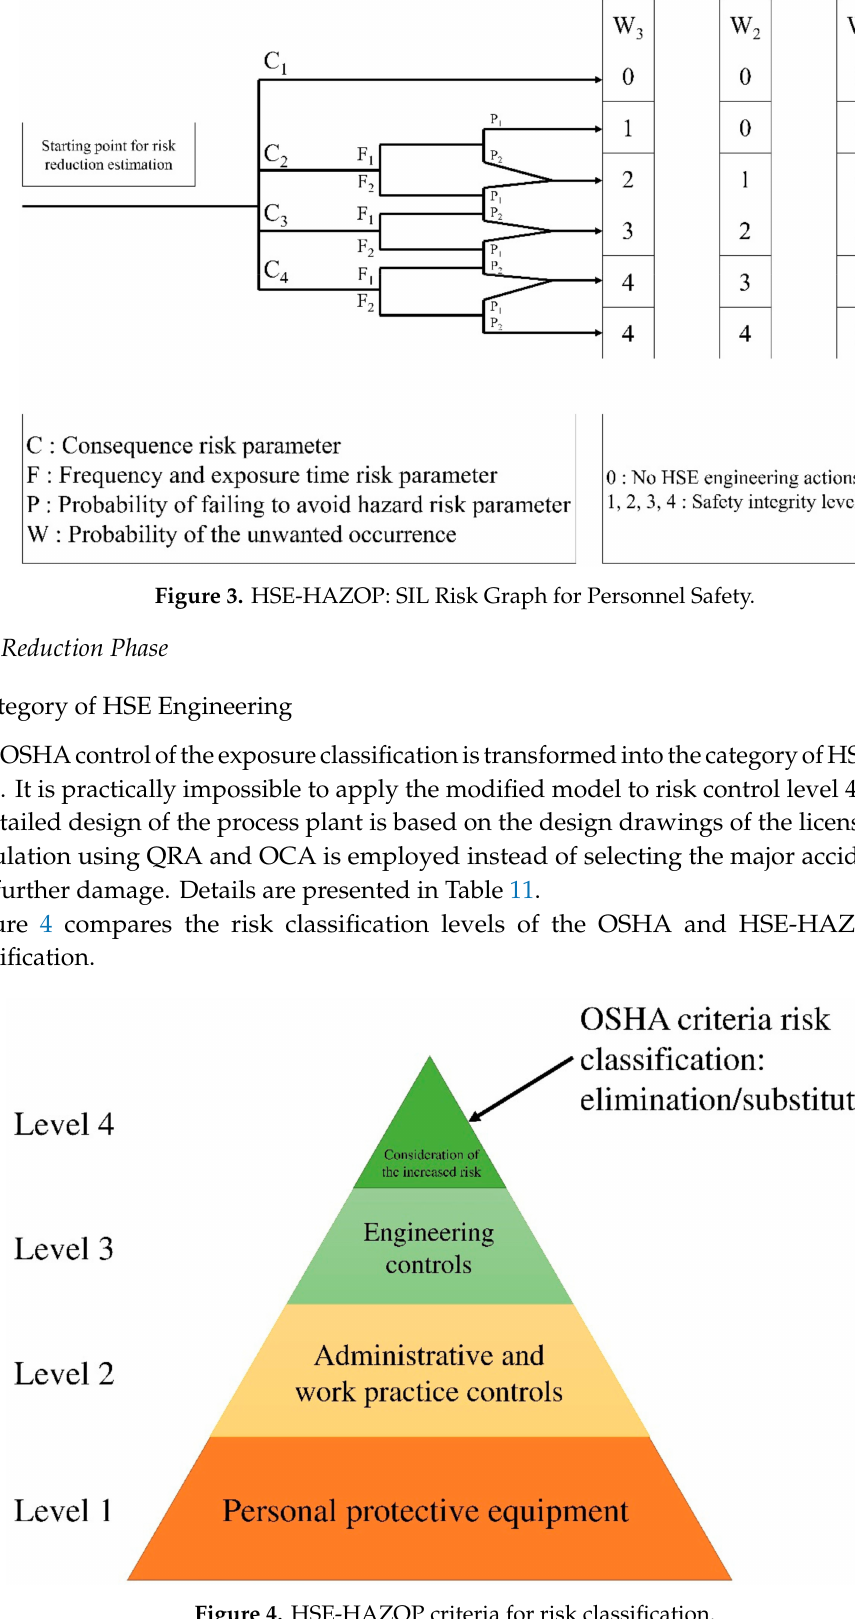
Figure 4. HSE-HAZOP criteria for risk